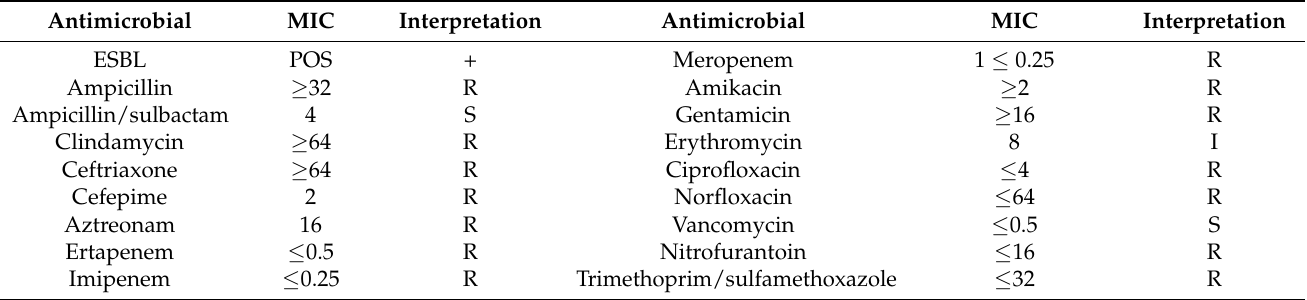
Table 3. VITEK 2 system for the identification and susceptibility testing of Staphylococcus aureus .